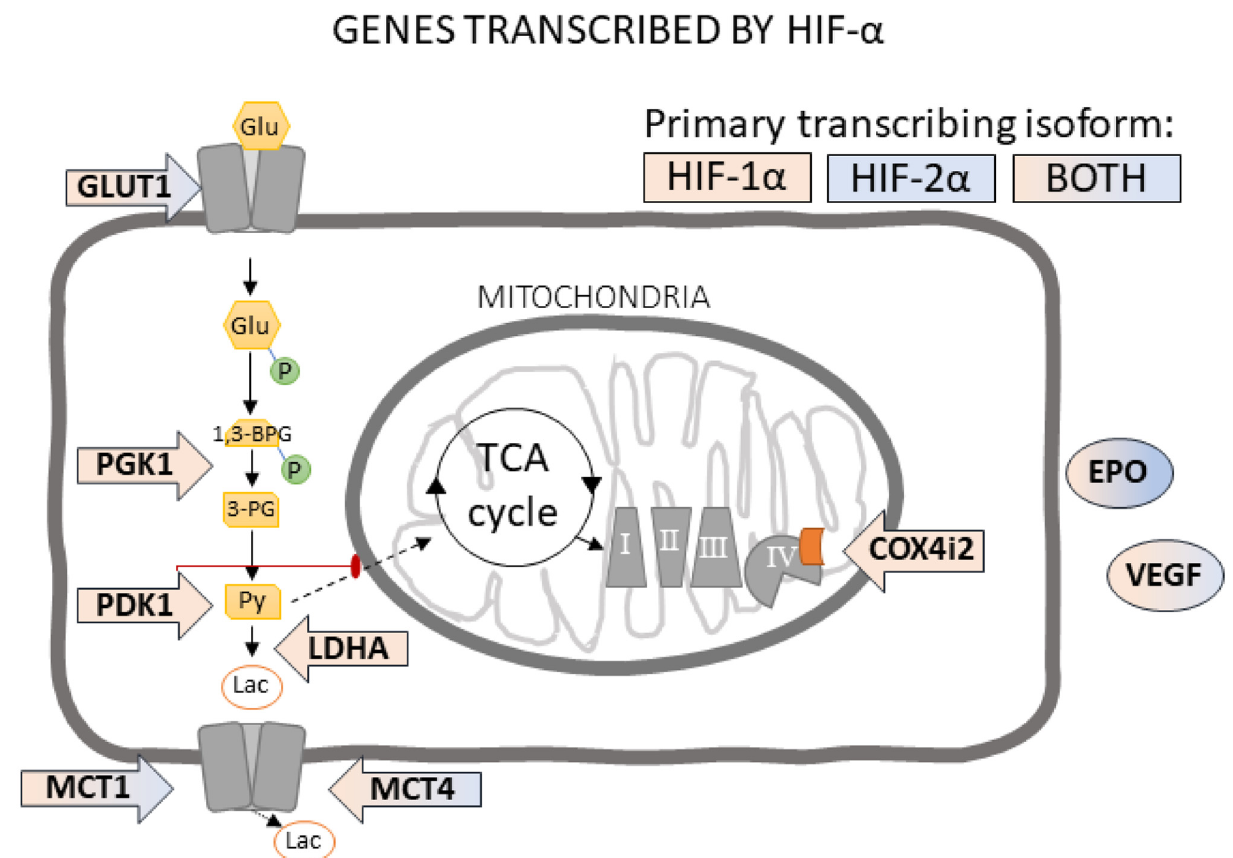
Figure 1. Genes of interest transcribed by HIF- α isoforms. HIF-1 α transcribes metabolic switching genes lactose dehydrogenase- A ( LDHA ), phosphoglycerate kinase 1 ( PGK1 ), pyruvate dehydrogenase kinase 1 ( PDK1 ), and switched cyclooxygenase 4 ( COX4 ) from isoform 1 to isoform 2. Both HIF- 1 α and HIF-2 α have been reported to transcribe glucose transporter 1 ( GLUT1 ), monocarboxylate transporters ( MCT ) 1 and 4, erythropoietin ( EPO ), and vascular endothelial growth factor ( VEGF ) in a cell-specific manner. HIF-2 α is particularly involved in modulating the EPO signal. Glu = glucose; 1,3-BPG = 1,3-biphosphoglycerate; 3-PG = 3-phosphoglycerate; Py = pyruvate; Lac = lactate; TCA = tricarboxylic acid cycle; I, II, III, and IV = complexes I, II, III, and IV of electron transport chain.